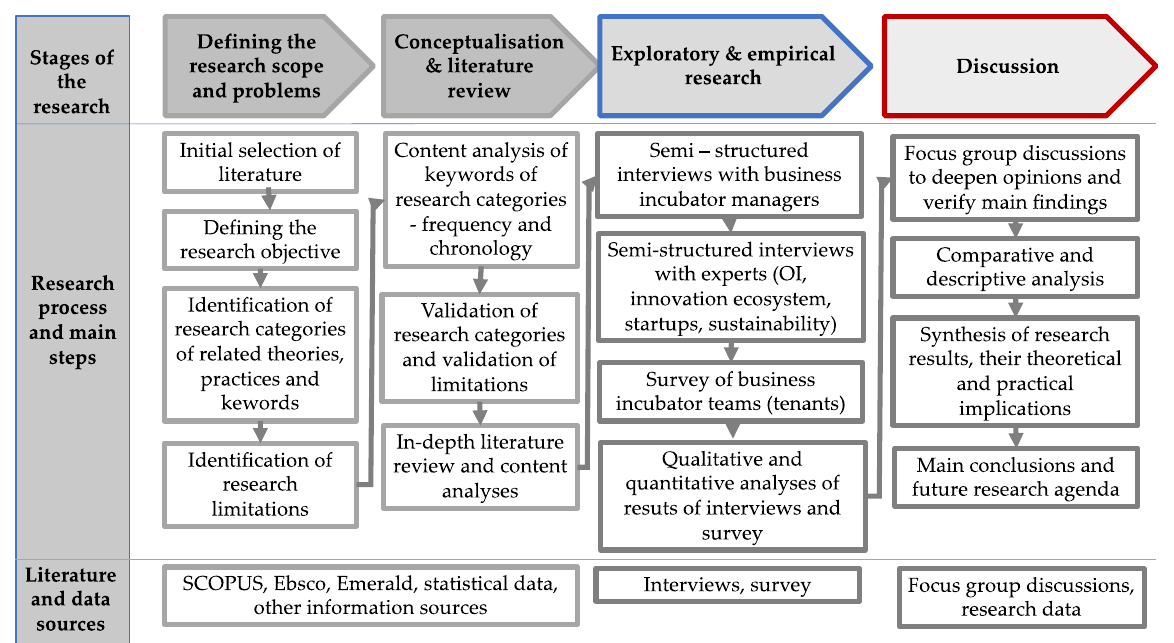
Figure 4. Methodological framework (source: the authors).